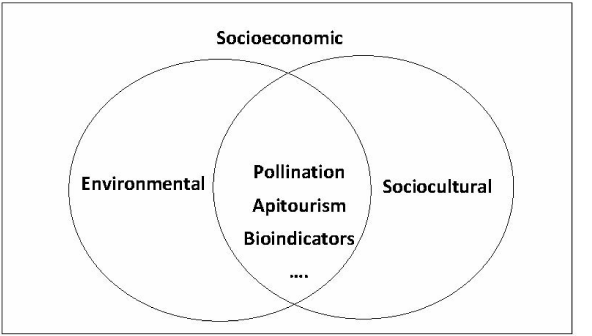
Figure 4. Interrelationships among the ecosystem benefits generated by beekeeping. Source: Own